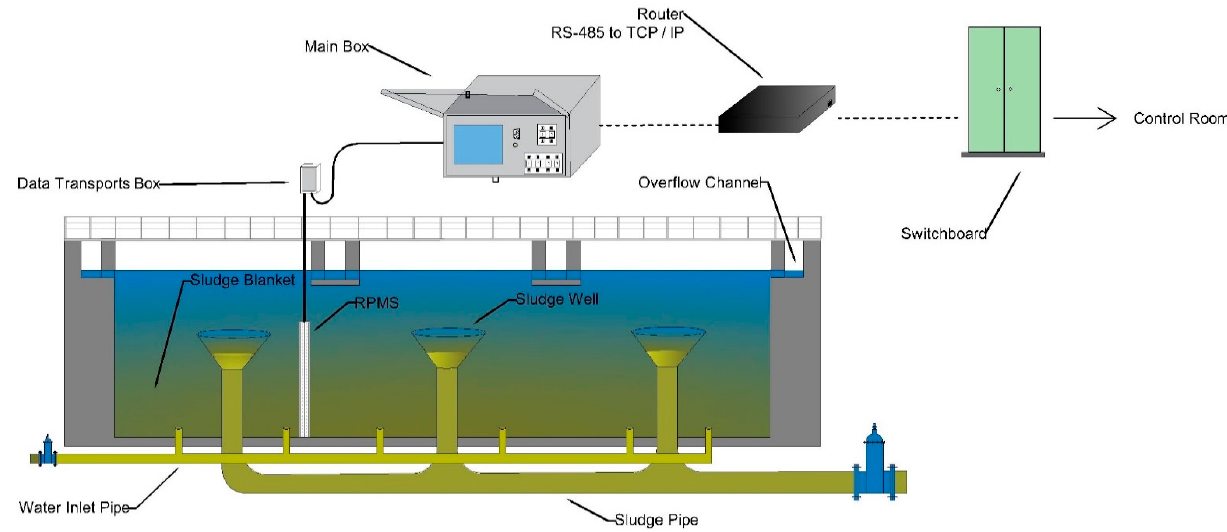
Figure 2. Experimental setup structure of the HFSBC.